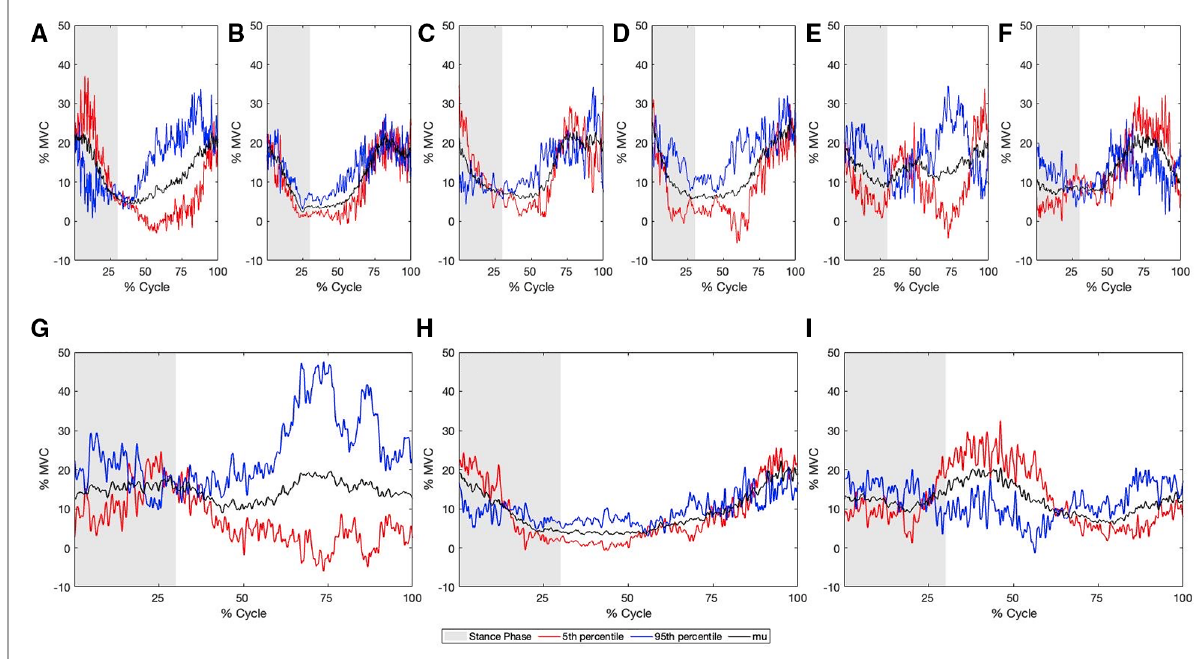
FIGURE 7 Multi-component reconstruction for PCs 1, 5, 21 and 22 derived from the sEMG for ( A ) GAS, ( B ) BF, ( C ) GMAX, ( D ) GMED, ( E ) LES, ( F ) LD, ( G ) EO, ( H ) VLO, ( I ) RF. Blue represents the 95th percentile sprinter (fast), Red represents the 5th percentile sprinter (slow), and grey represents the stance